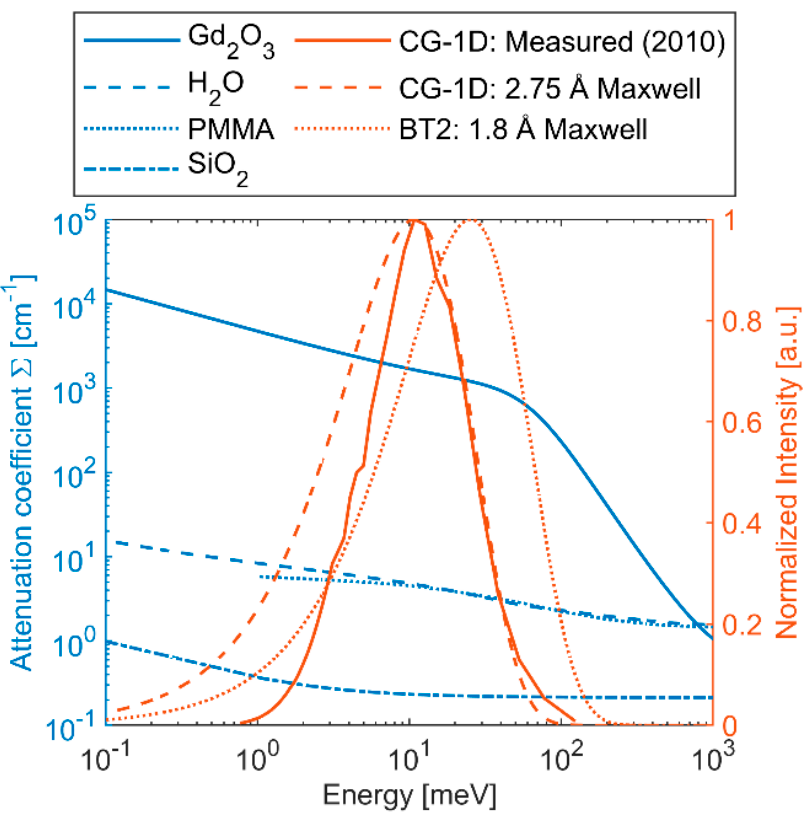
Figure 2. Energy-resolved attenuation coefficients for Gd 2 O 3 [13,14], H 2 O [16], PMMA [17], SiO 2 [13,14], and spectra for CG-1D and BT2 instruments. Table 1. Required Gd 2 O 3 thickness ( μ m) to achieve given attenuation.